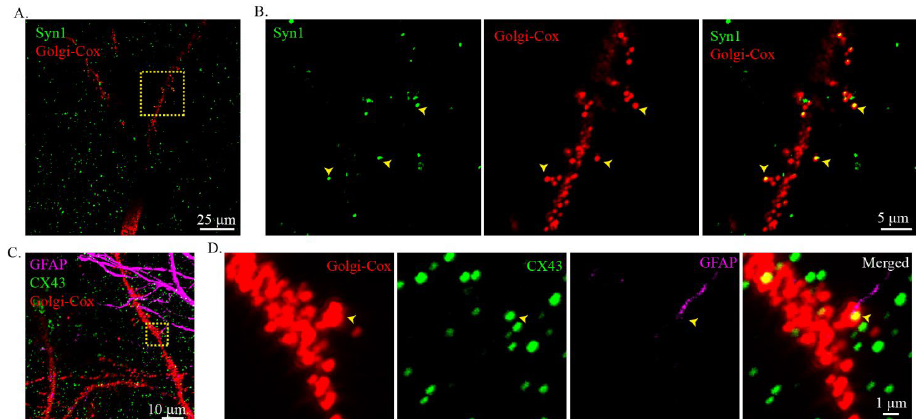
Figure 6. Reconstruction of the neuronal circuit at the dendritic spine level with the combination of Golgi-Cox staining and immunostaining. ( A ) Visualization of the connection between immunostain labeled pre-synaptic protein, Syn1, and Golgi-Cox-stain-labeled post-synaptic dendritic spines. The Golgi-Cox-stained signal was obtained using the confocal reflective mode of the confocal microscopy and the immunostained signal was obtained using standard confocal imaging. ( B ) Zoomed-in images from the insert in ( A ) showing the contact of the pre- and post-synaptic structures. The yellow arrows show the contact site. ( C , D ) Visualization of the connection between astrocytes and neurons. ( C ) Visualization of the immunostain labeled astrocyte (GFAP), gap junction (CX43), and Golgi-Cox-stain-labeled neural fibers. The Golgi-Cox-stained signal was obtained using the confocal reflective mode of the confocal microscopy and the immunostained signal was obtained using the standard confocal imaging mode. ( D ) Zoomed-in images from the insert in ( C ) showing the colocalization of the process of the astrocyte, CX43, and dendritic spine.